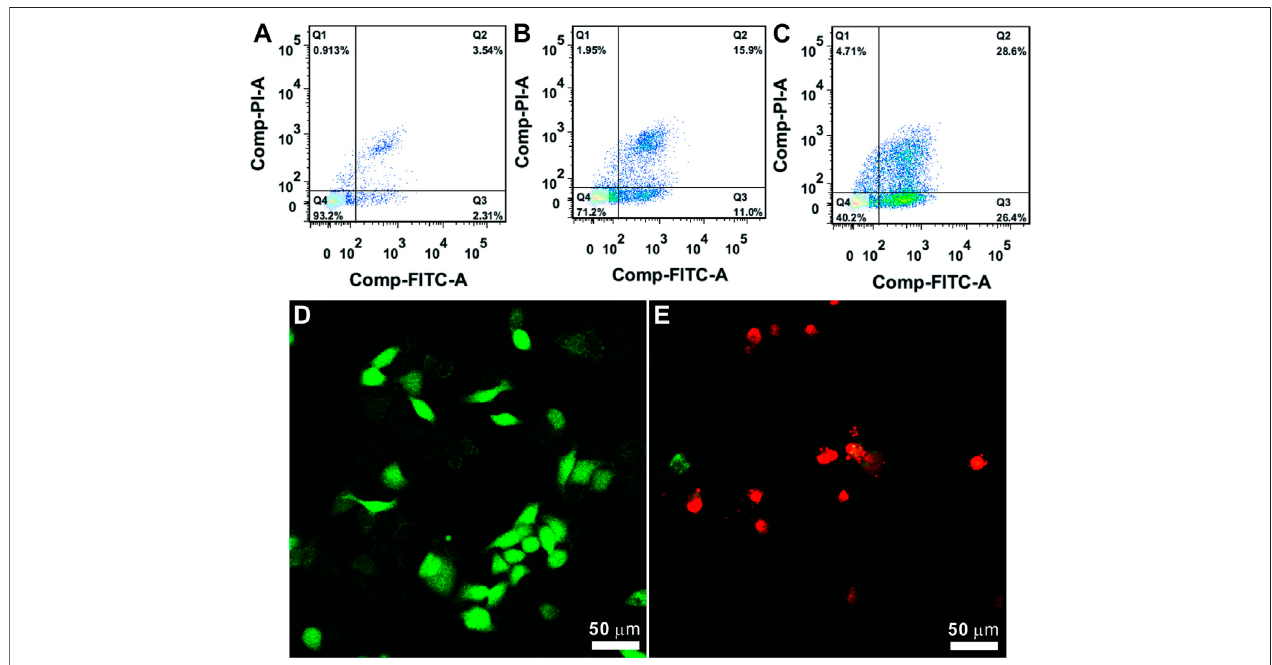
FIGURE 4 | (A – C) Cell apoptosis analysis using the PI/annexin V-FITC double staining method: (A) control; (B) Ag/QAS-MSNs, 10 ppm; (C) Ag/QAS-MSNs, 20 ppm. Q1: necrosis, Q2: late apoptosis, Q3: early apoptosis, Q4: live. (D,E) Cell morphology of the dying cells induced by Ag/QAS-MSNs suggested a form of apoptosis: (D) control; (E) Ag/QAS-MSNs, 20